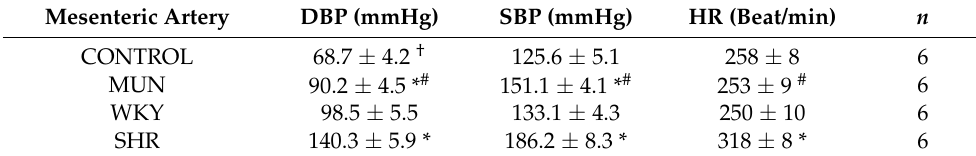
Table 1. Blood Pressure and Heart Rate from CONTROL/MUN and WKY/SHR